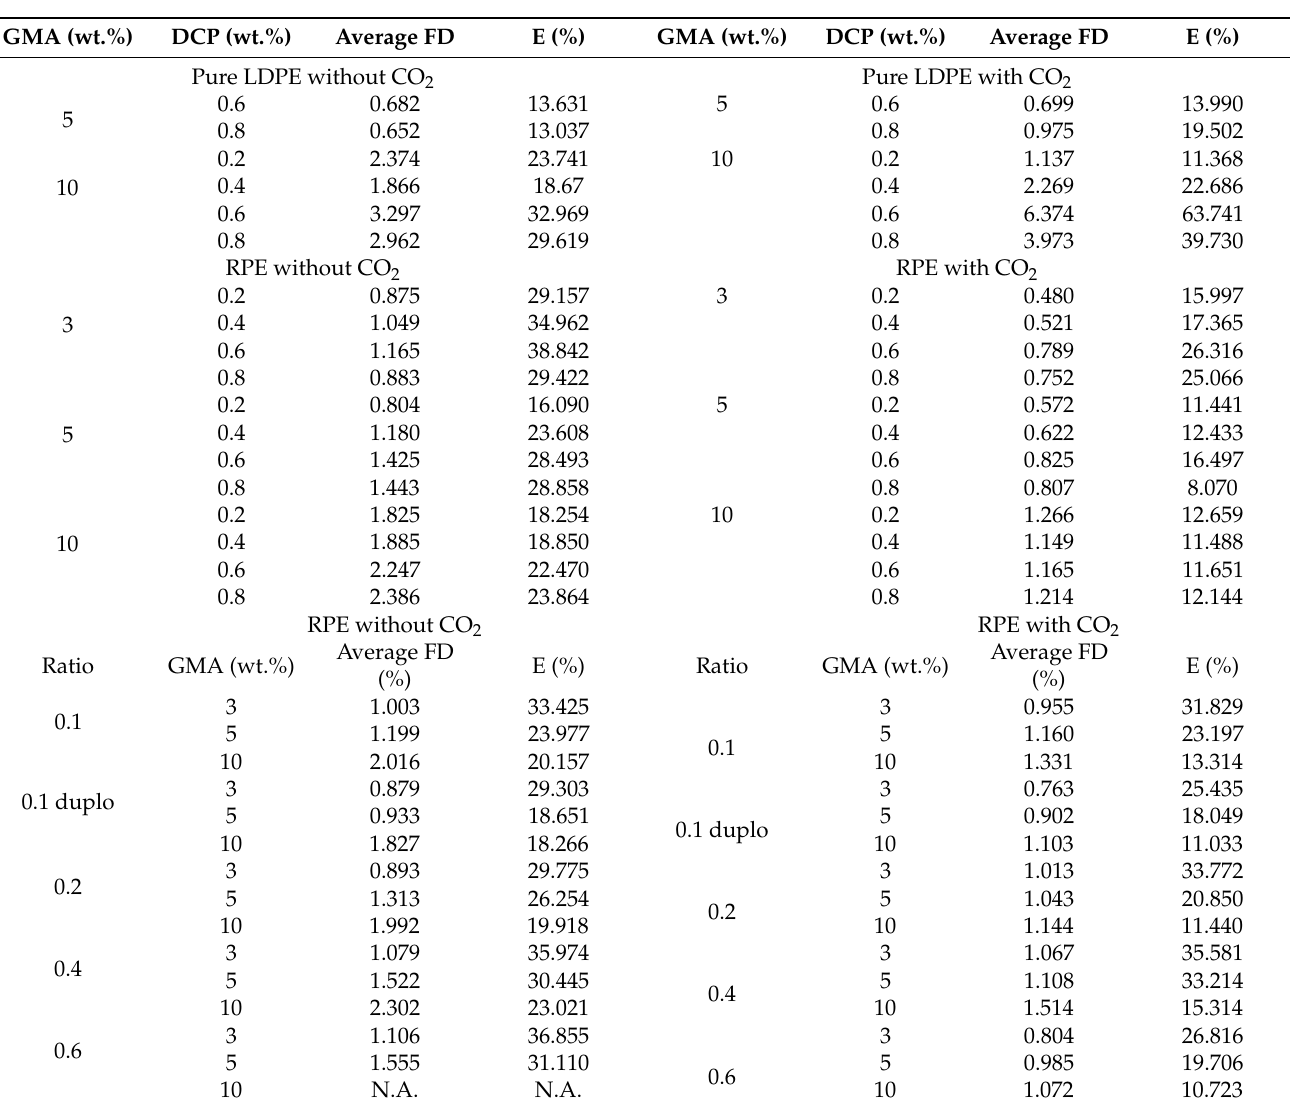
Table A1. Extruder temperature: 175–180–185–180–175 ◦ C. Screw speed: 20 rpm. PscCO 2 : 130 bar. Flowrate: 4 g/min.